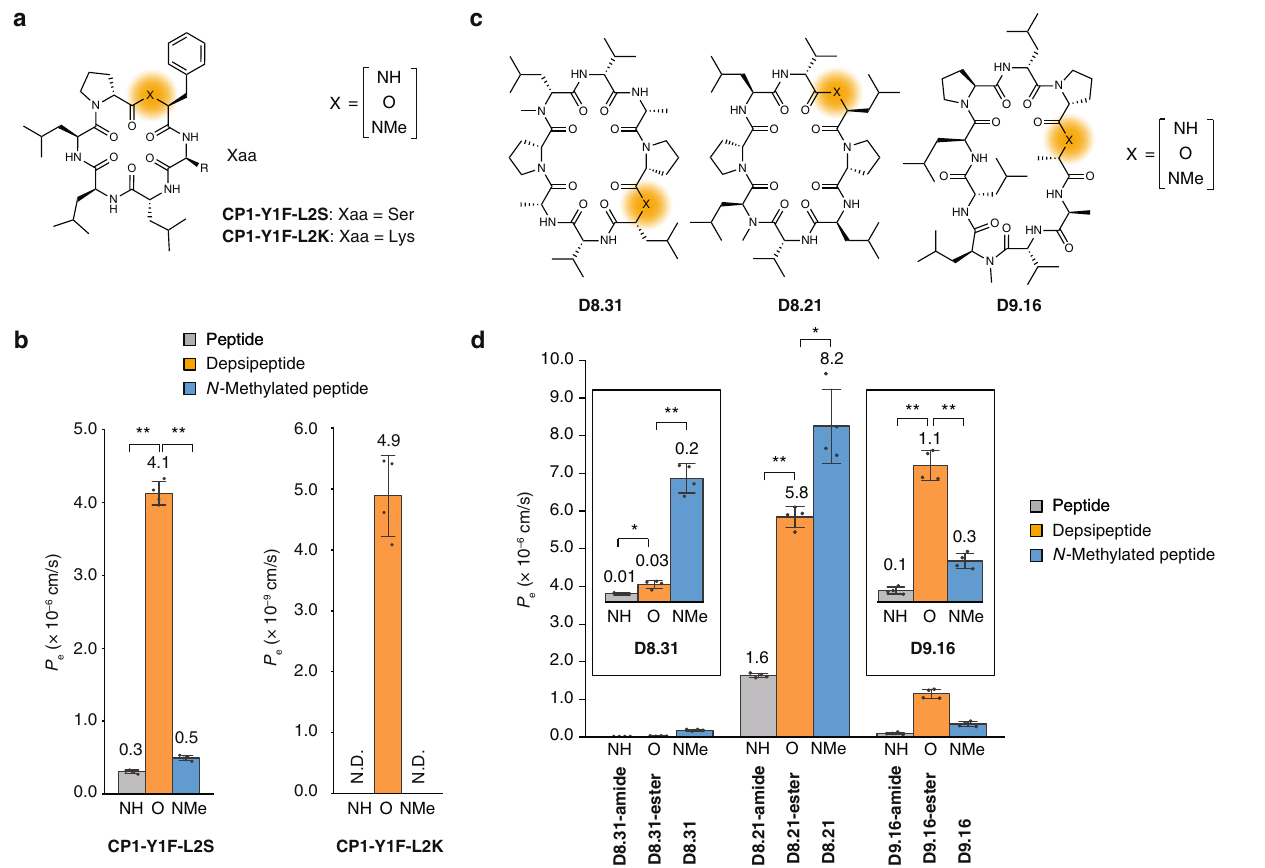
D9.16-ester ). d PAMPA of cyclic 8-mer and 9-mer peptides. The enlarged views of the results of D8.31 series and D9.16 series are shown in the insets. PAMPA was conducted with 3 μ M compounds in PBS containing 5%DMSO and 16h incubation at 25°C. Each bar represents the mean value, and the error bars the standard deviationfromexperimentscarriedoutinquadruplicate. p ( D8.31-amide vs.